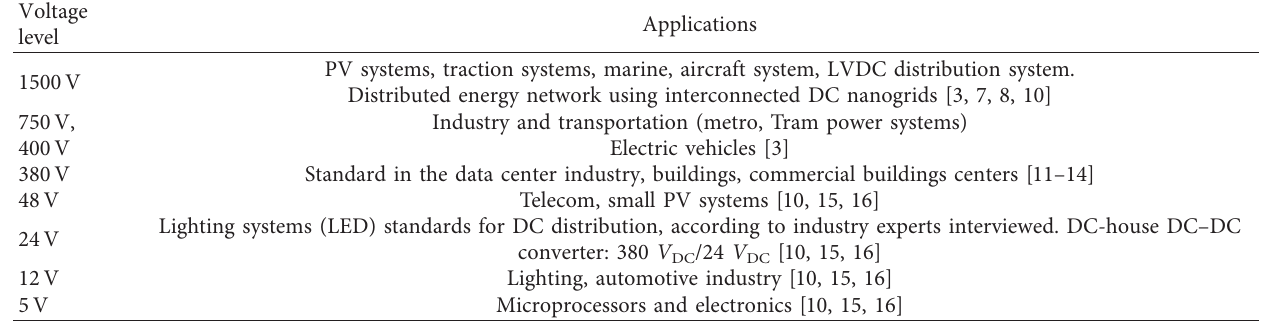
Table 1: Main DC voltage levels and applications.